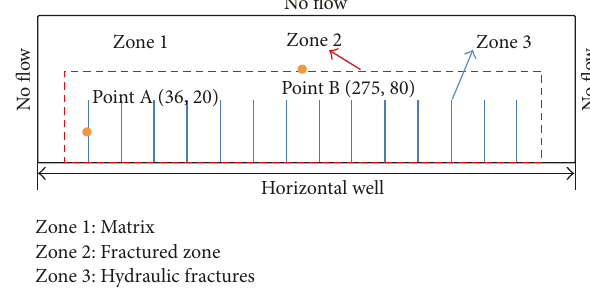
Figure 3: Computational model for fractured shale